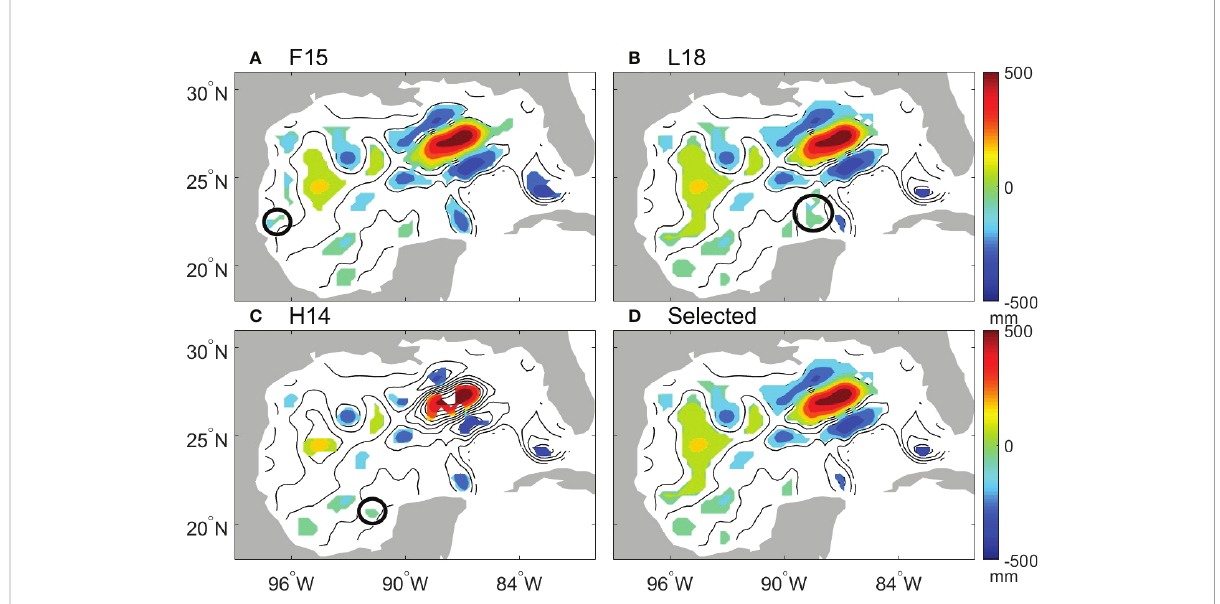
FIGURE 2 Snapshots of the high-passed ADT (contours) and detected eddies (color shading) on 20 March 1995. Eddies were detected by (A) F15 algorithm, (B) L18 algorithm, (C) H14 algorithm, and (D) eddies were selected by a combination of the three algorithms. The black circle in (A – C) encloses the eddy that was detected by one algorithm but not detected by the other two